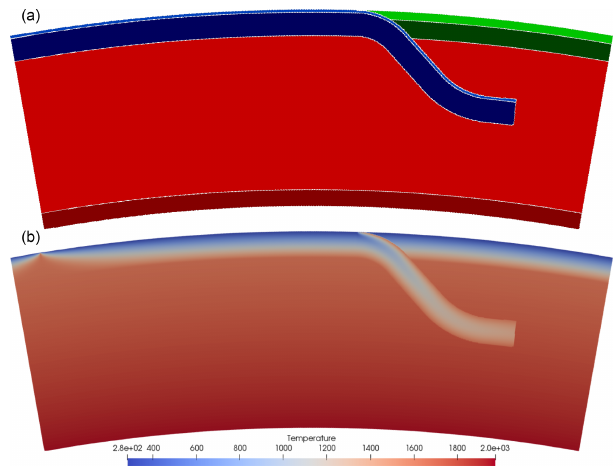
Figure 2. The same as setup as in Fig. 1 but now in spherical geom- etry. Panel (a) shows the composition; panel (b) shows the temper-